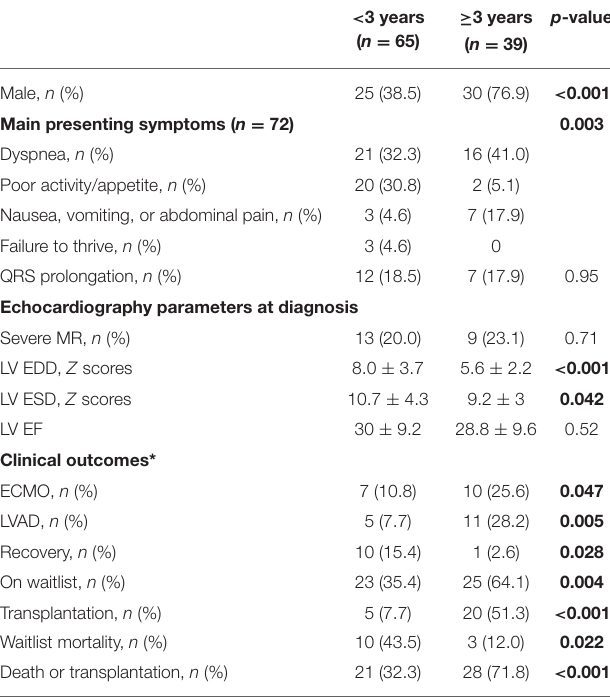
TABLE 2 | Comparisons between patients with a diagnostic age < 3 years and ≥ 3